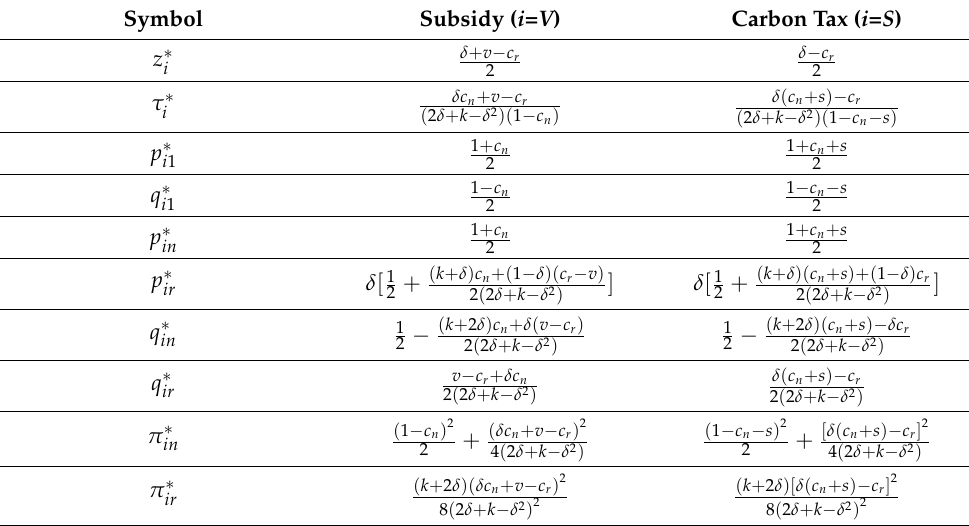
Table 2. The optimal solution under two different government policies.